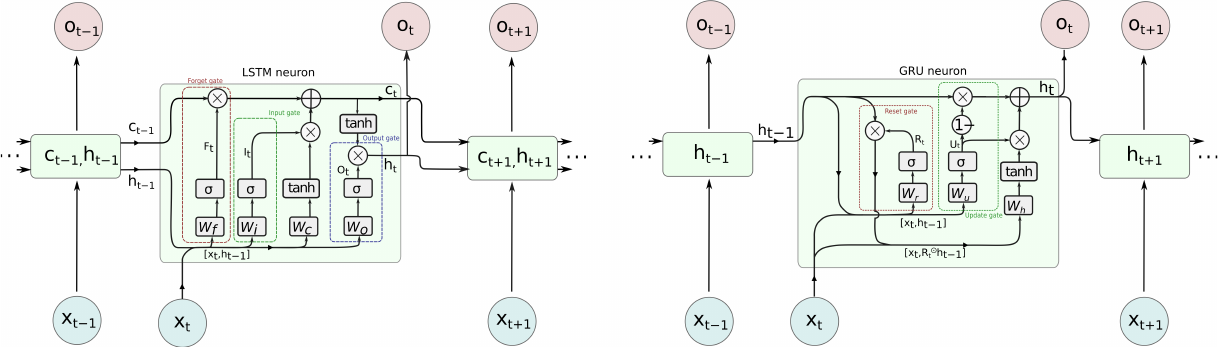
Figure 5. LSTM ( left ) and GRU ( right ) neurons in